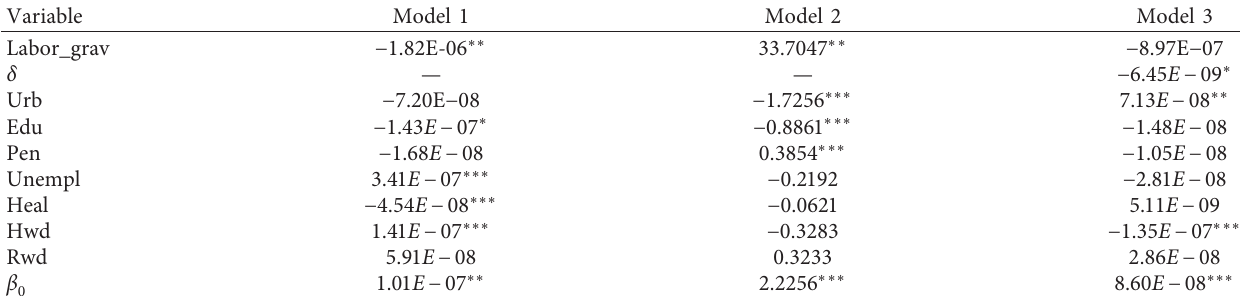
Table 5: The estimation results of 25 provinces and Malmquist index is the mediator variable.